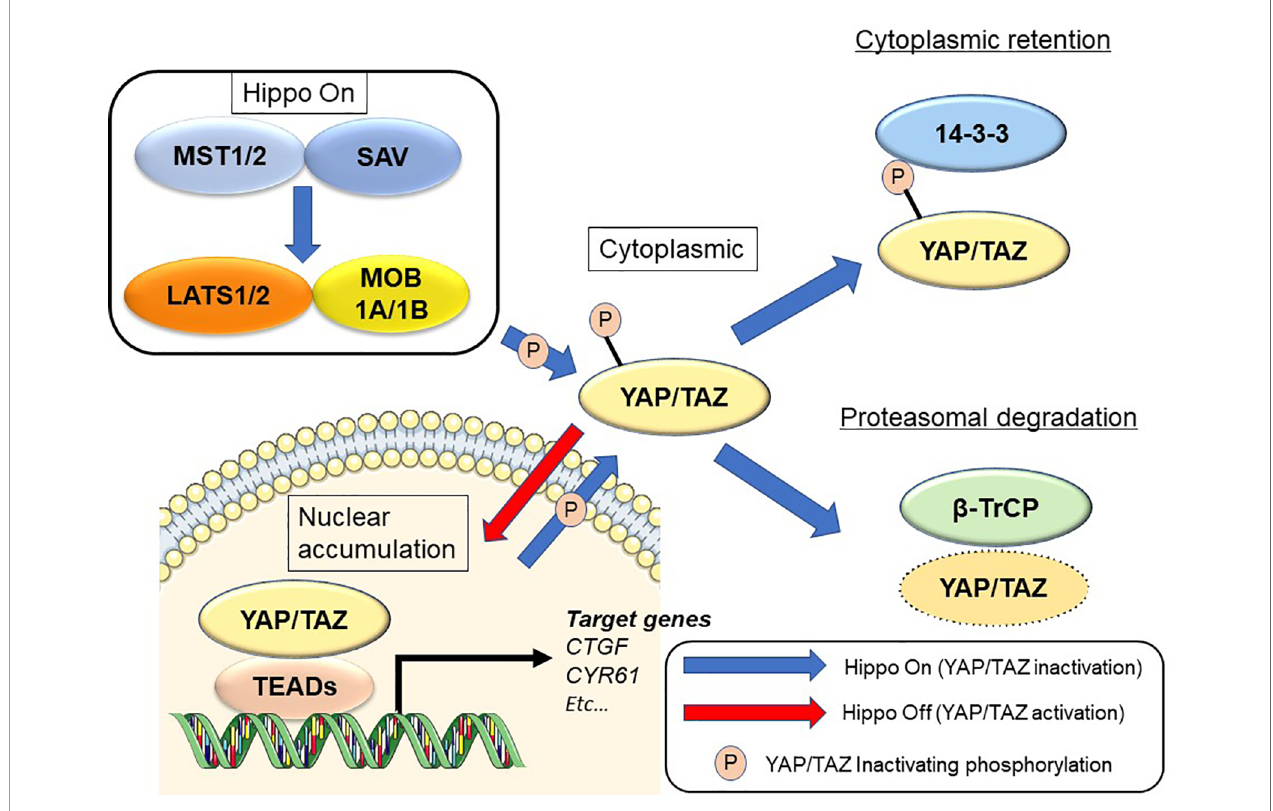
FIGURE 1 | Regulation of the Hippo signaling pathway in mammalian cells. See text for